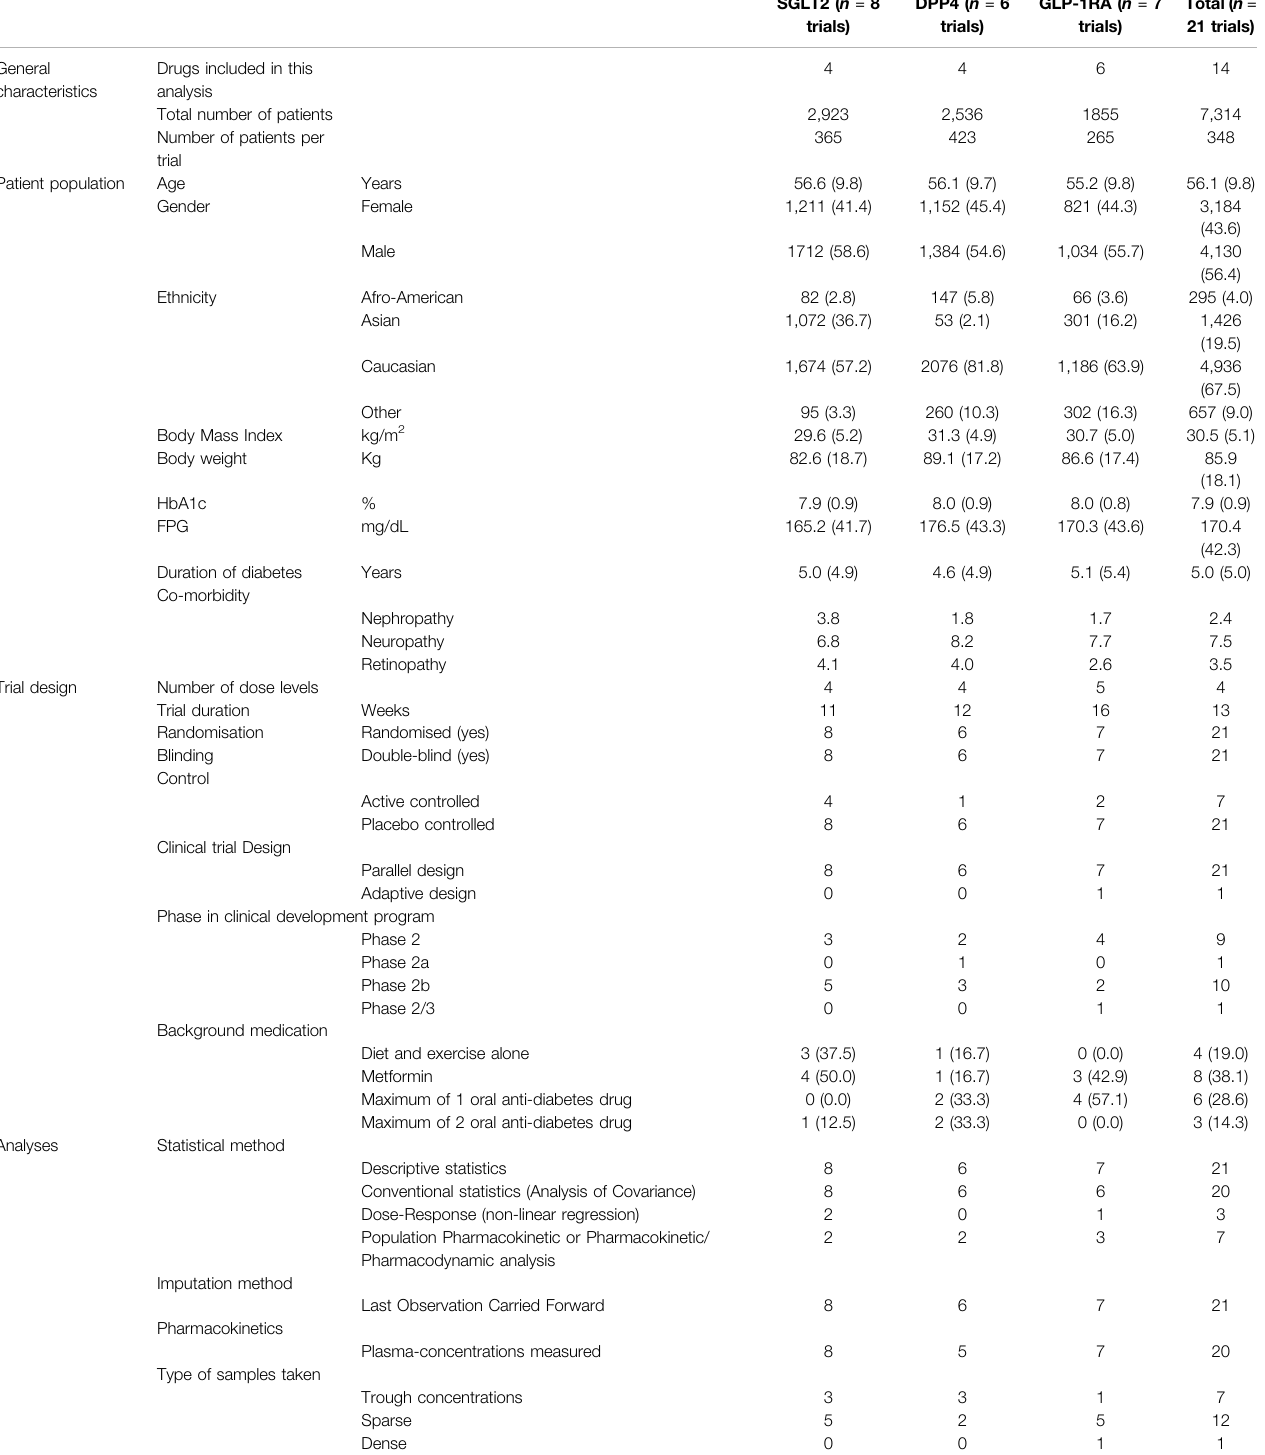
TABLE 1 | Characteristics of the primary dose- fi nding trials used in justi fi cation in clinical